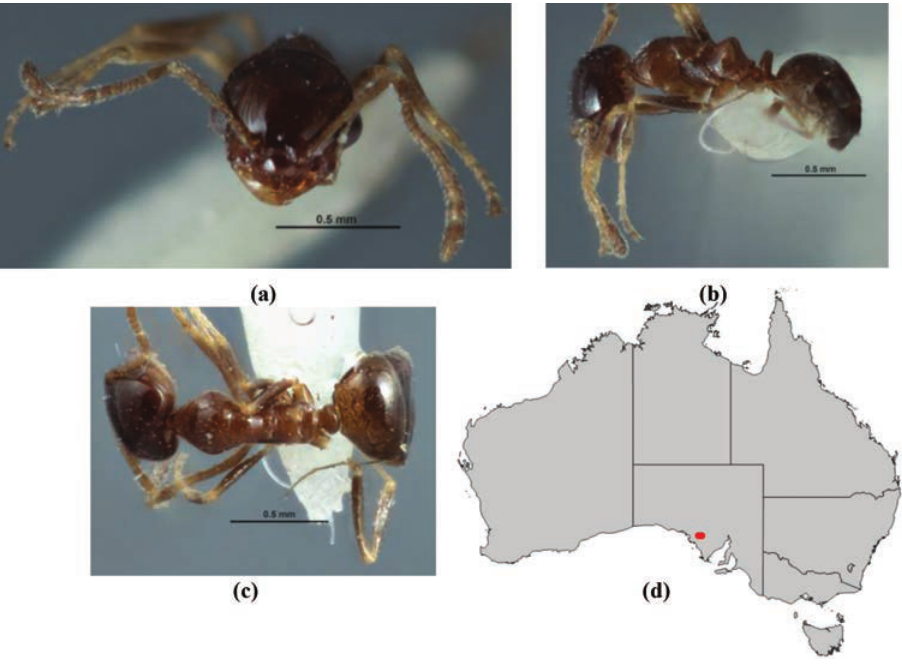
Figure 47. Melophorus turbineus sp. n.: minor worker holotype (ANIC32-066636–bottom ant) frons ( a ), profile ( b ) and dorsum ( c ); distribution map for the species ( d